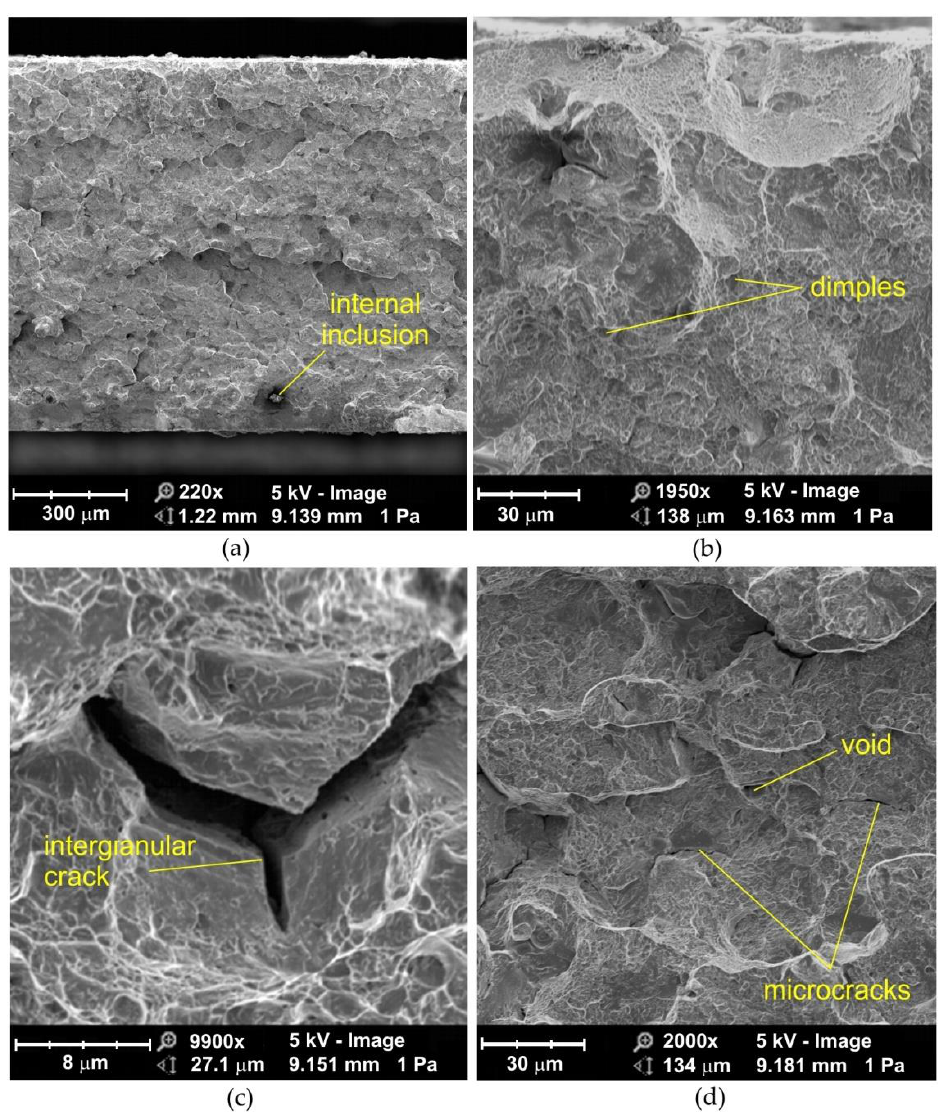
Figure 7. SEM micrographs of the fracture surface of sandblasted flash butt welded joints tested at a stress amplitude of 690 MPa: ( a ) cross-section of the fractured surface, ( b ) view of the near-edge layer of the weld, ( c , d ) magnification of the middle area of the weld.